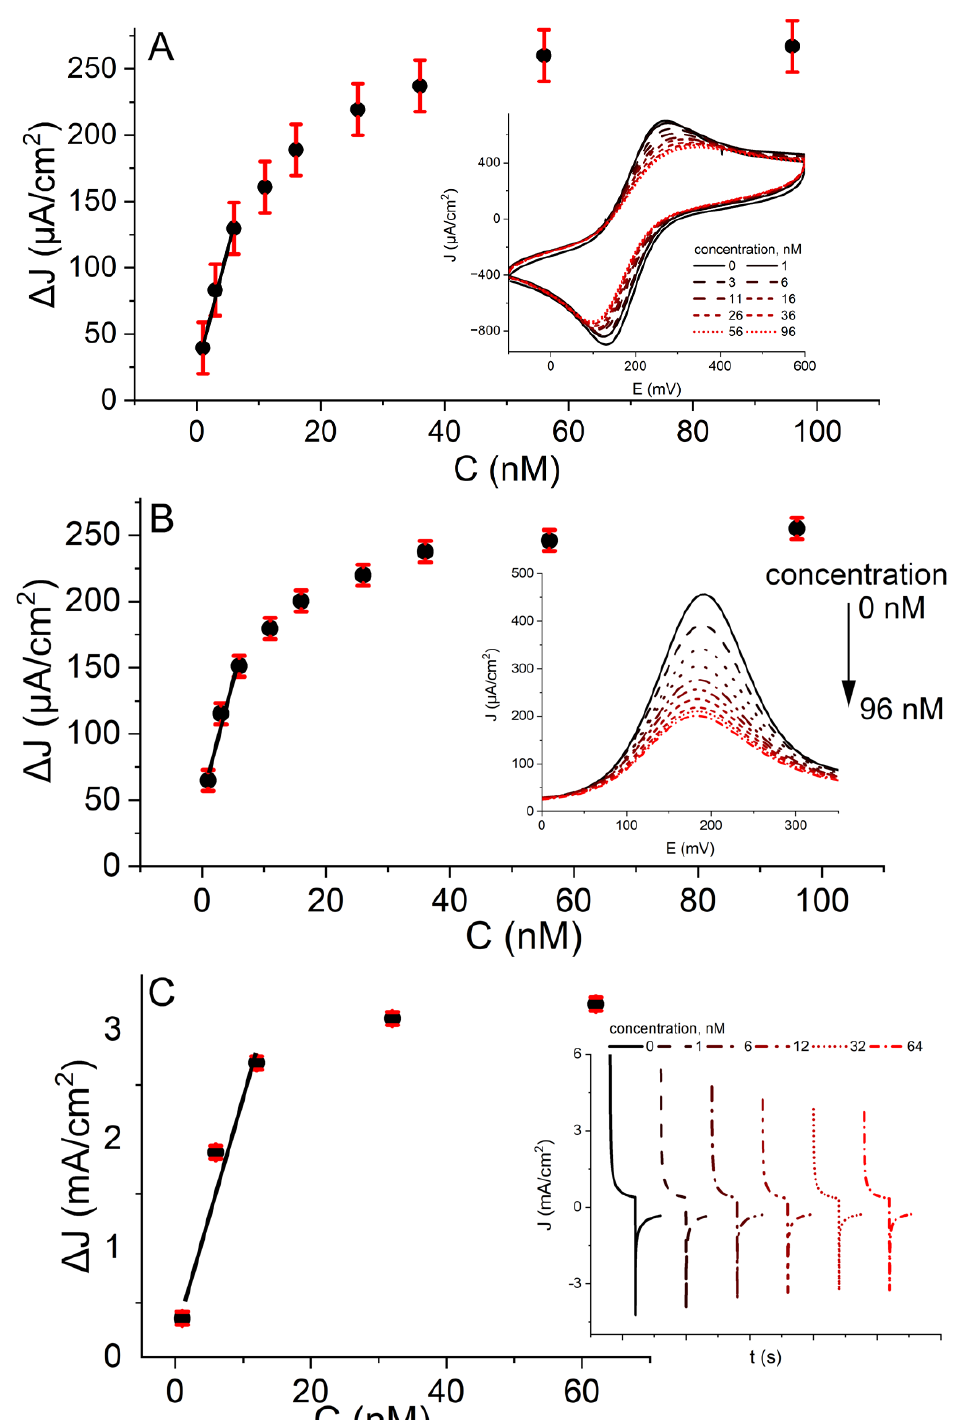
Figure 4. The evaluation of anti-rS antibody interaction with the rS protein, which was immobilized on the polycrystalline gold electrode, was performed by three electrochemical methods: cyclic voltammetry ( A ), differential pulse voltammetry ( B ), potential pulsed amperometry ( C ). Measurements were performed in PBS solution (pH 7.4) while adding 2 mM of [Fe(CN) 6 ] 3− and 2 mM of [Fe(CN) 6 ] 4− as a redox probe; the current density was calculated taking into account the surface area of the electrode (0.071 cm 2 ).